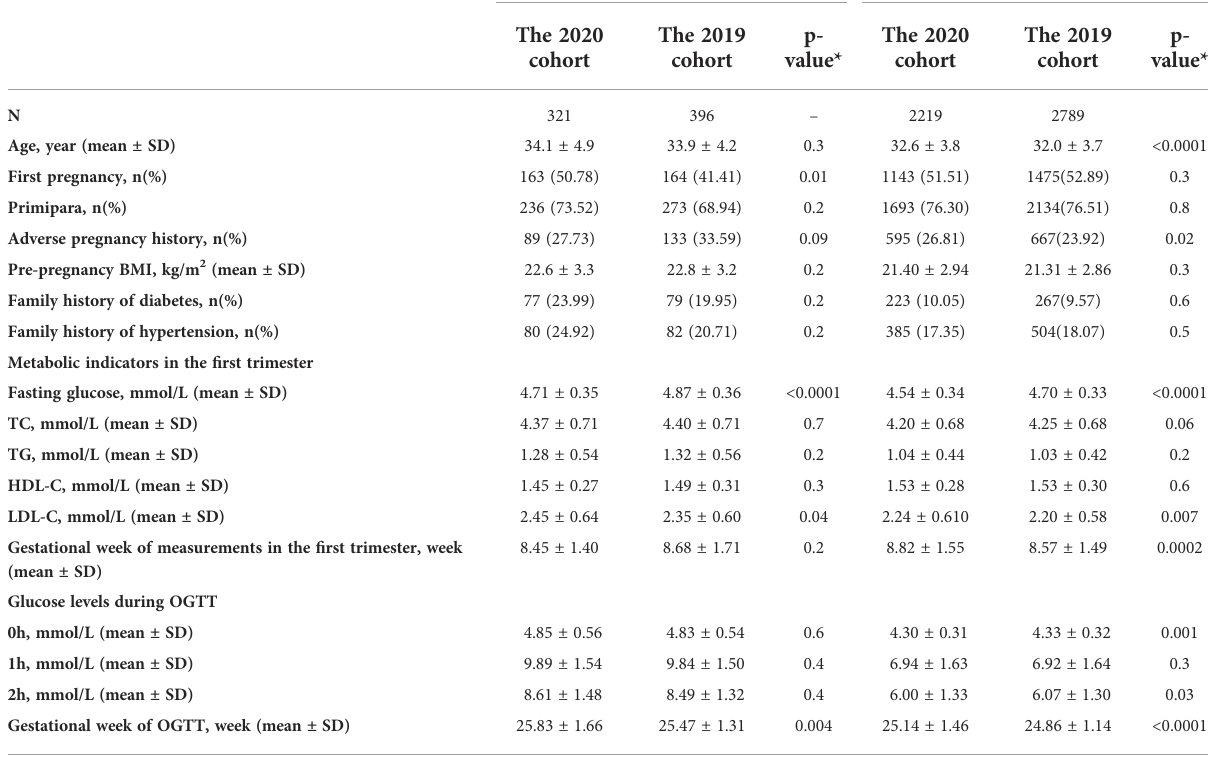
TABLE 1 Baseline characteristics of the